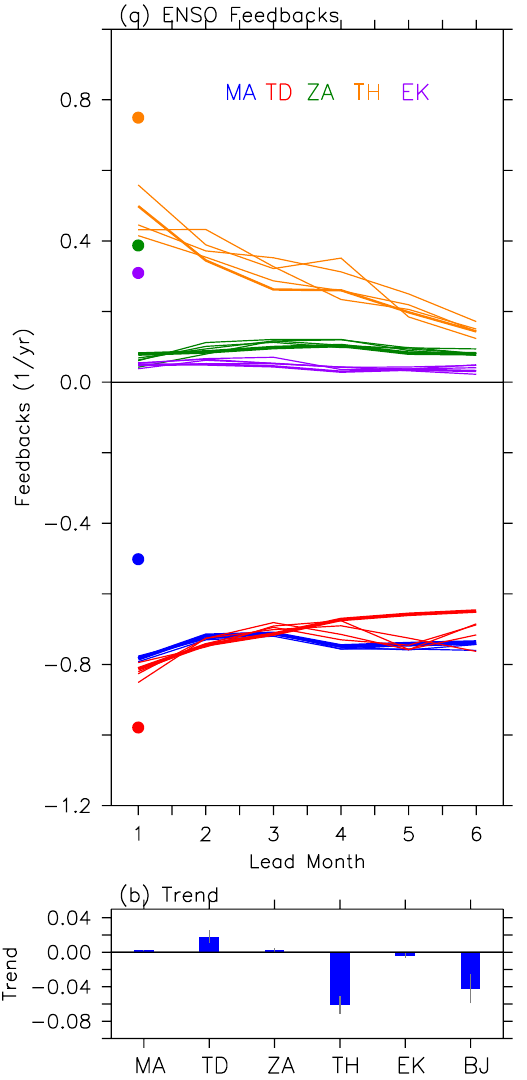
Figure 3. ENSO feedback errors. ( a ) Feedback terms in BJ index from predictions calculated at each forecast lead time. Blue (lines and dot) is mean advection damping (MA), red is thermodynamic damping (TD), green is zonal advective feedback (ZA), orange is thermocline feedback (TH), and purple is Ekman feedback (EK). Colored dots indicate results from observations. Solid lines indicate results from individual forecasts. ( b ) Trend (yr − 1 lead mon − 1 ) of each BJ index feedback term over forecast lead times. Blue bars show an average of all member forecasts and gray vertical lines show inter-ensemble member spread as estimated with standard deviation of trends from individual member